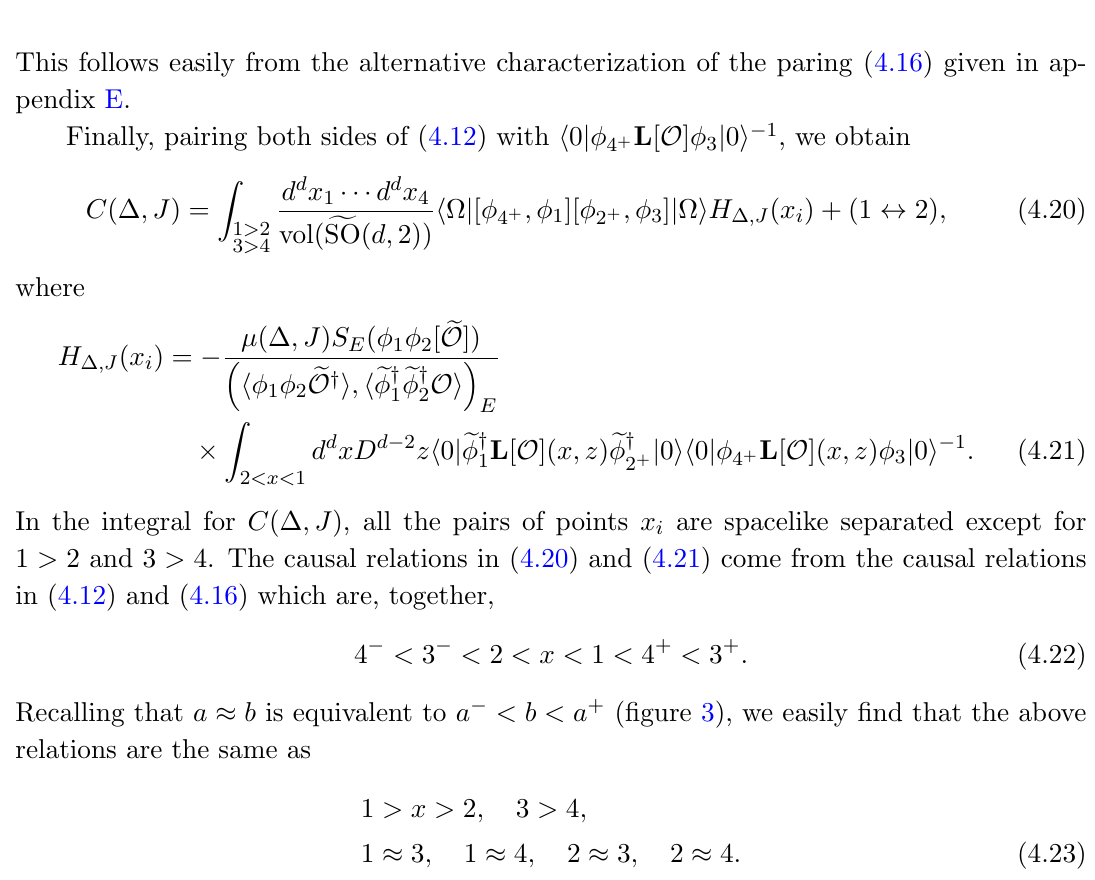
Figure 10. After (temporarily) relabeling the points 2 (cid:0) ! 2 and 4 (cid:0) ! 4, we have a con(cid:12)guration where 1 > x > 2 and 3 > 4, with all other pairs of points spacelike separated. This is the same con(cid:12)guration as in (cid:12)gure 17 of appendix H.2, where we compute the Lorentzian integral for a conformal block. The integration region for x is shaded yellow. Importantly, it stays away from 3 ; 4, so the 3 ! 4 limit can be computed inside the